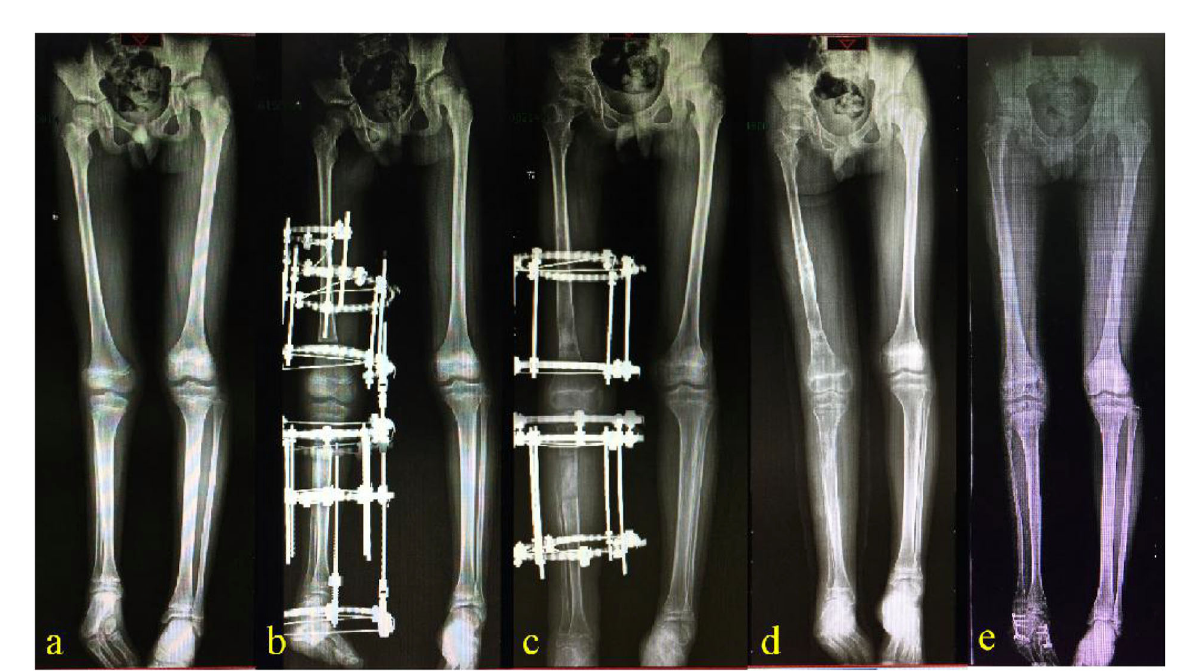
FIGURE1 Anteroposterior X-ray view. (a) An 11.5-year-old boy showed congenital fibular deficiency with a total 8.8cm shortening of the right femur and tibia, genu valgus, and was missing lateral feet in an equinovalgus position . (b) A double Ilizarov frame, including a femoral segment and a tibial segment, were connected with two straight/flexure device on the level of the knee joint. (c) The bony callus was observed almost consolidated 28 weeks after operation after lengthening, lasting for 5 weeks on the femur and 8 weeks on the tibia. (d) After 40 weeks of the operation, the double-Ilizarov frame was removed. (e) At a 3.5-year postoperative follow-up, the limb length discrepancy was